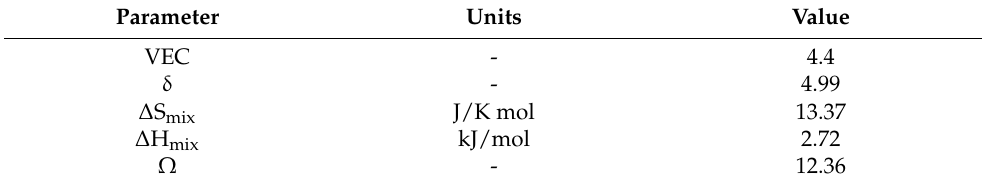
Table 2. Calculated thermodynamic parameters for the HfNbTaTiZr HEA alloy.